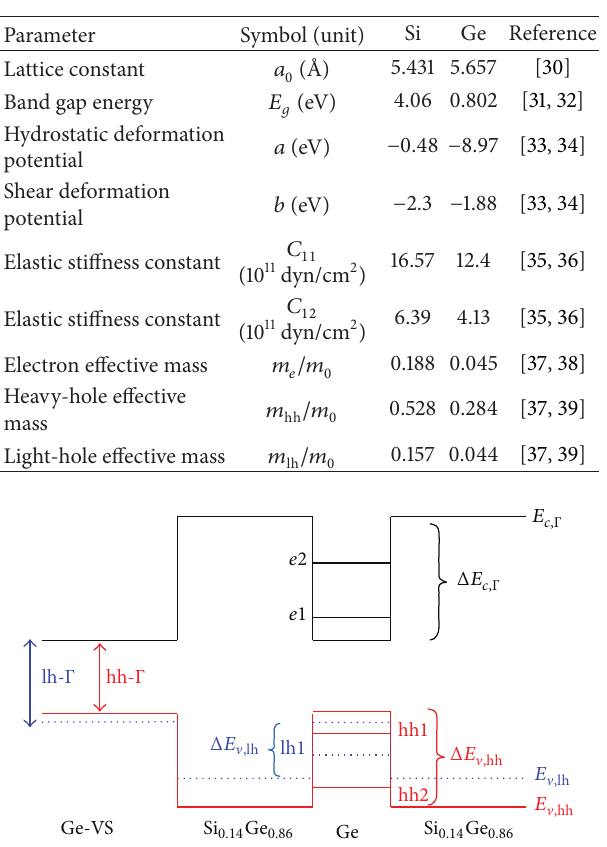
Table1:Parametersofbandgapenergy,strainrelatedconstants,and effective mass for the Ge/SiGe material system.